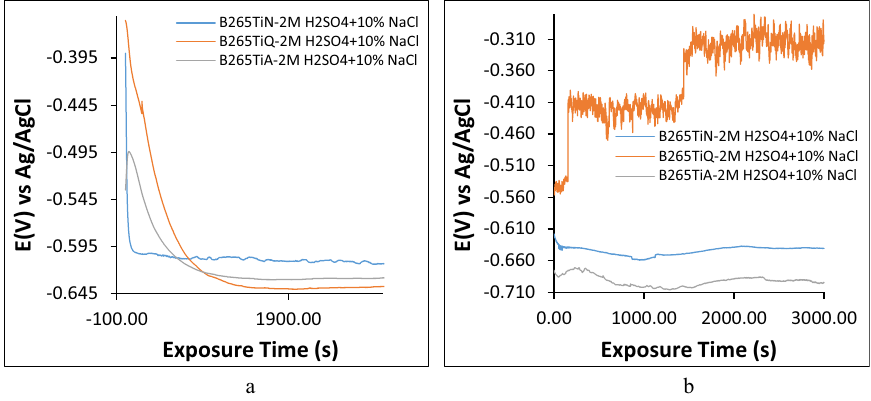
Figure 12: OCP plots of B265TiN, B265TiQ, and B265TiA alloy corrosion in 2 M H 2 SO 4 + 10% NaCl solution at ( a ) 30°C and ( b )